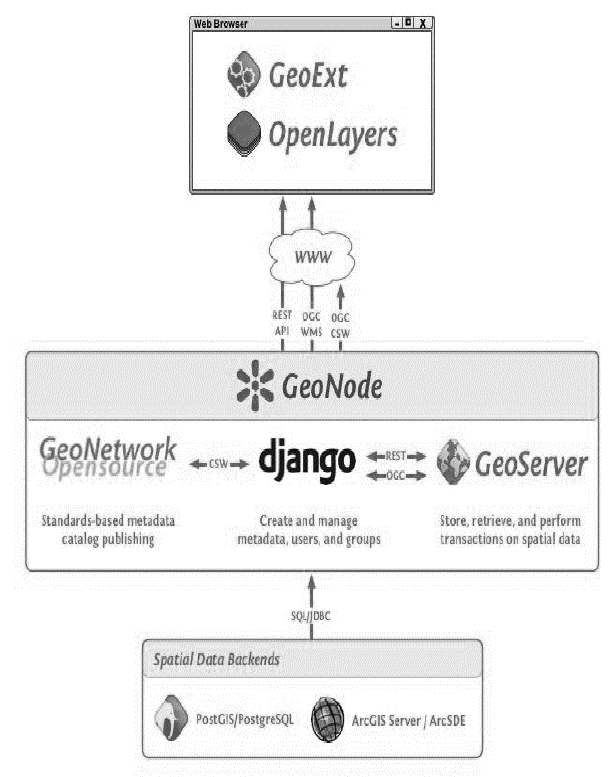
Figure 3. The SMACiSYS Spatial development